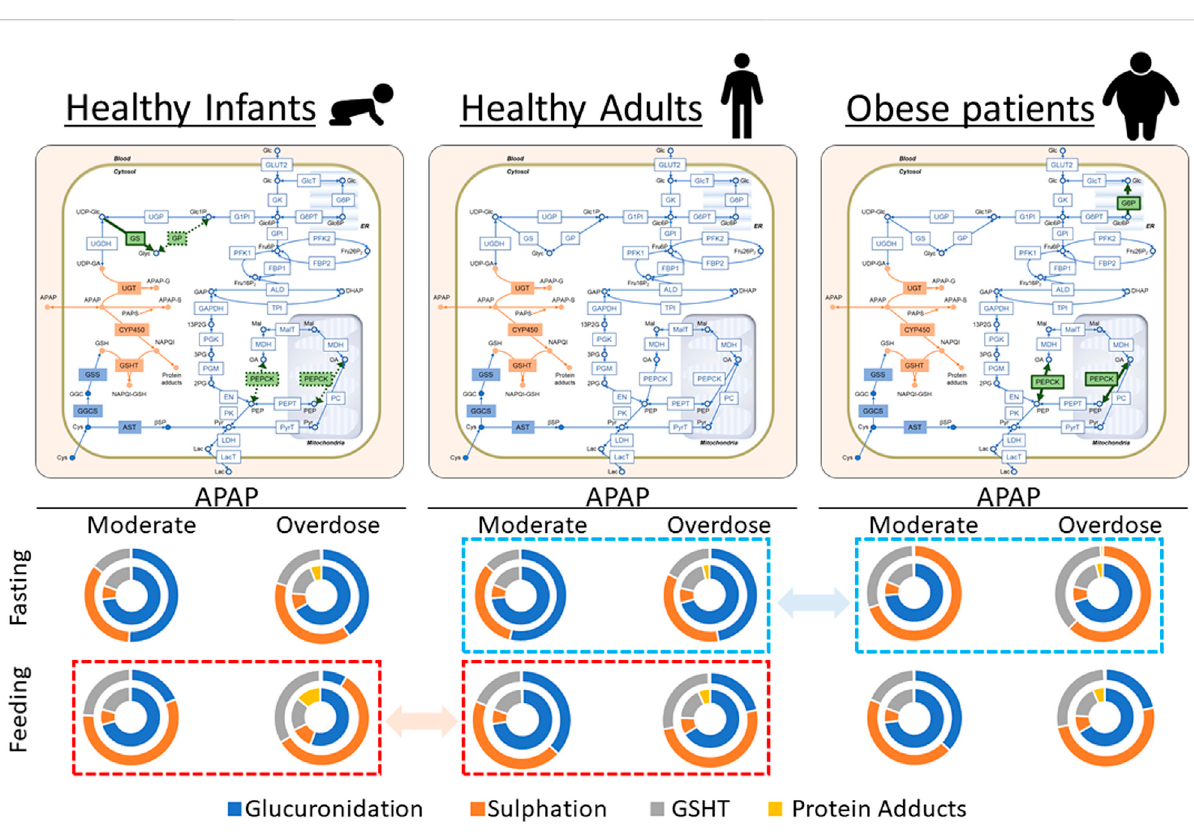
FIGURE 6 Visual representation of the results in Tables 1, 2, and 3. Acetaminophen (APAP) was administered for the initial 30 min at 0.5 mM/h (moderate dose)or6.0 mM/h(overdose)undereither4 mM(fasting) or11 mM(feeding)ofbloodglucose.ThereactionratesofAPAPmetabolicpathwayswere integrated up to 5 h, and the results are shown as relative contributions to APAP metabolism in pie charts. In each chart, the outer and inner circles represent the results in the periportal and pericentral regions, respectively. The activities of phosphoenolpyruvate carboxykinase (PEPCK) and glucose-6-phosphate phosphatase (G6P) increased in obese adults compared with healthy adults. Furthermore, the glycogen synthase activity increased, and PEPCK and glycogen phosphorylase activities decreased in healthy infants compared with healthy adults. The modi fi ed enzymatic activities are highlighted in green on the network maps. Dashed squares (red to red and blue to blue) highlight the prominent differences in relative contributions of APAP metabolic pathways among three model cases.